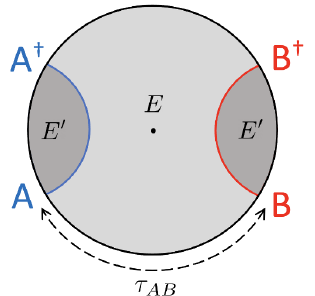
Figure 4 . Two shell solution when E < E 0 . The central region, with energy E , contains fixed point of the isometry, but the other two regions do not contain fixed points. The operators A and B are separated by a positive Euclidean evolution τ AB > 0 .